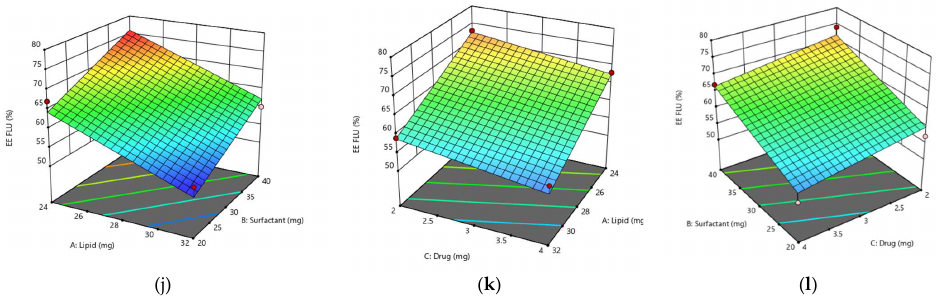
Figure 2. 3D response surface graphs: effects of lipids, surfactants and drugs on particle size ( a – c ); zeta potential ( d – f ): % entrapment efficiency of acitretin ( g – i ): % entrapment efficiency of fluocino-